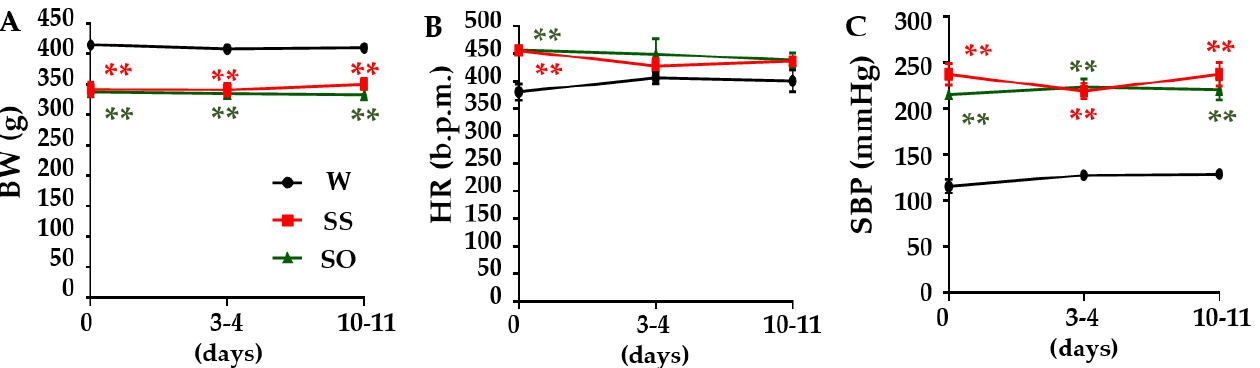
Figure 1. Human omentin-1 had no effect on body weight (BW), heart rate (HR), or systolic blood pressure (SBP) in spontaneously hypertensive rats (SHR). Male SHR (65 – 68-week-old) were subcutaneously injected with saline (0.14 mL/day, n = 4; SS) and human omentin-1 (18 μ g/kg/day, n = 4; SO) by using an implanted osmotic pump for 14 days. Male Wistar Kyoto rats (WKY) were sham operated (n = 4; W). BW ( A ) was measured once a week. HR ( B ) and SBP ( C ) were measured by a tail-cuff method (before the injection (0) and 3–4 and 10–11 days after the injection). The results were expressed as means ± standard error of the mean (S.E.M.). b.p.m.; beats per minutes. ** p < 0.01 vs. W (two-way ANOVA followed by Holm–Sidak post-hoc